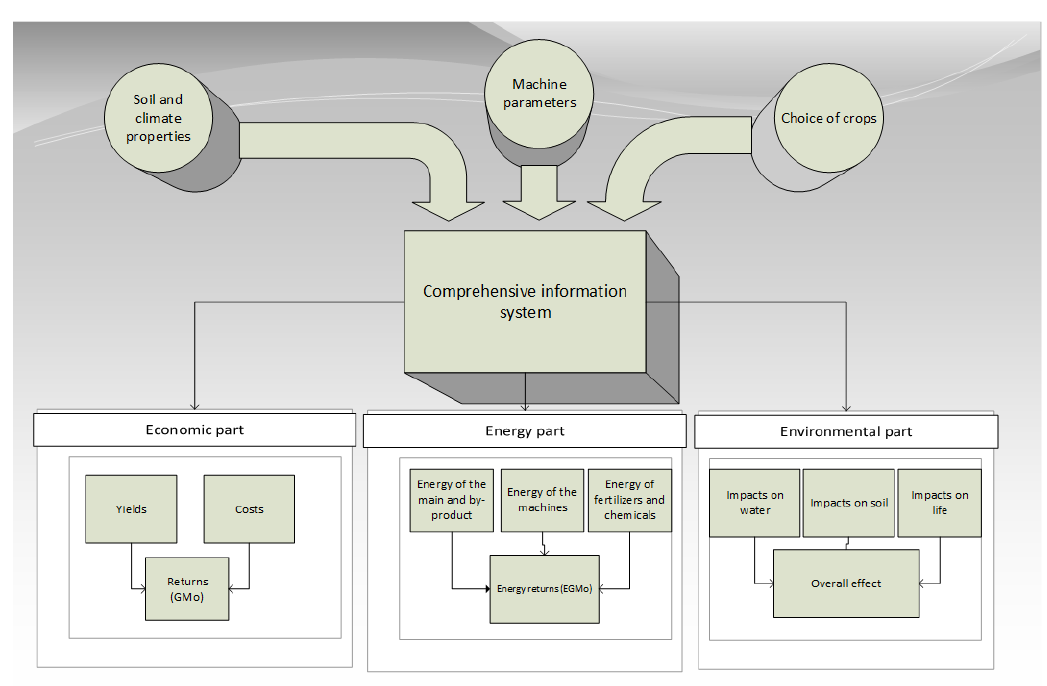
Figure A1. Scheme of the Comprehensive Information